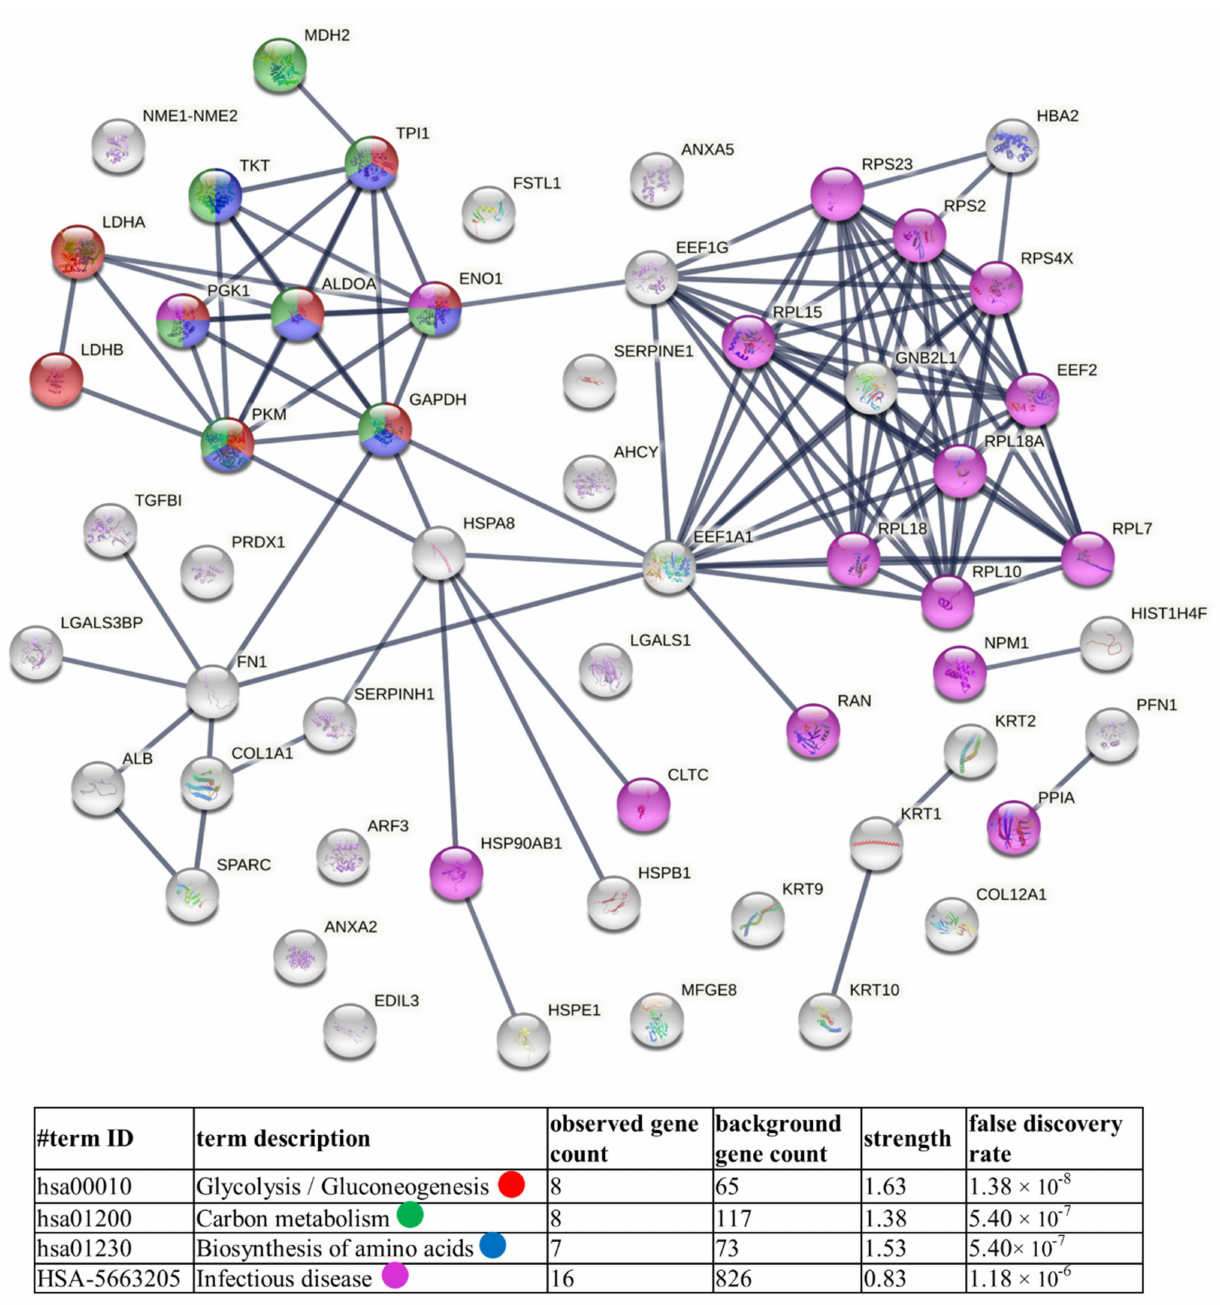
Figure 7. Diagram of functional protein association networks prepared with the use of STRING v. 11.0 software for 5% of the most abundant proteins identified in Nthy-ori 3-1-derived ectosomes (i.e., 57 proteins). The selected strongly represented pathways are presented as an interactome. Complete results are provided in Supplementary Data